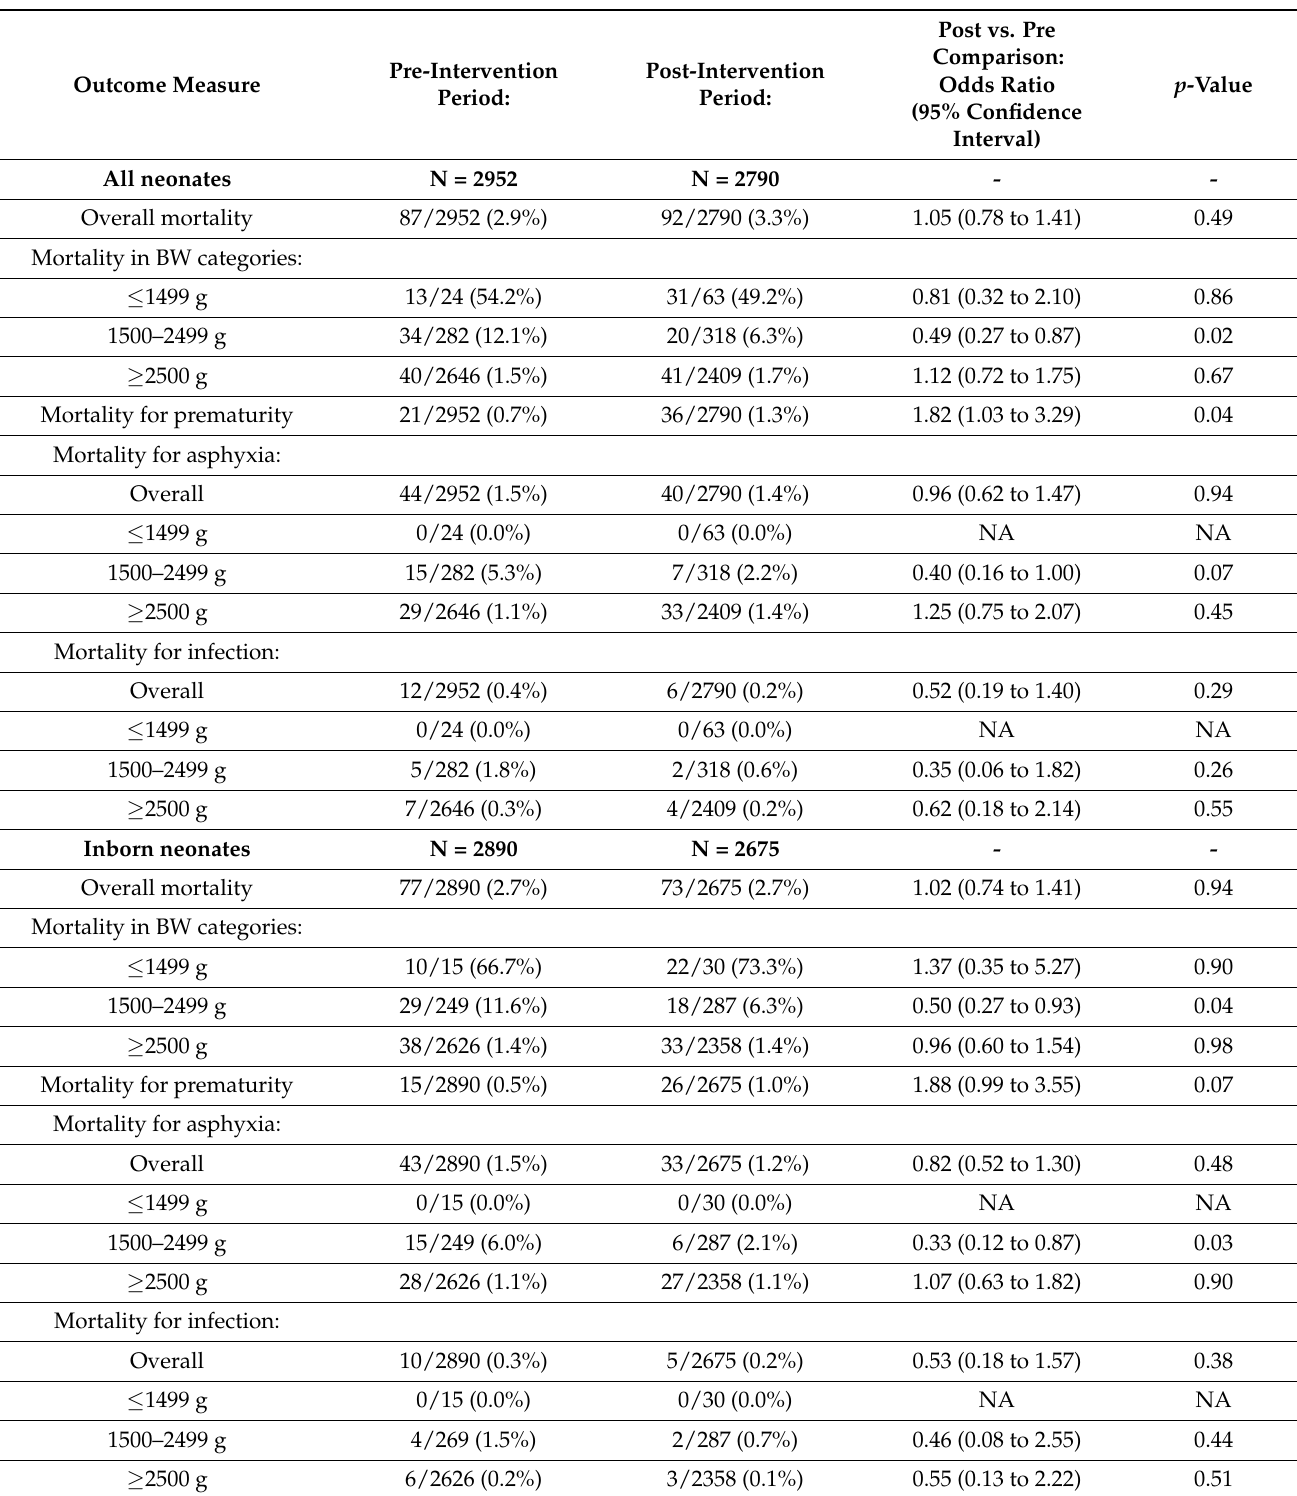
Table 3. Comparison of mortality of neonates admitted to the SCU in the pre- vs. post-intervention